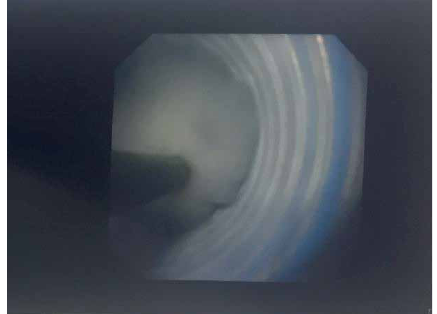
Figure 2: Fungal tissue inside basket within the ureteral access sheath.